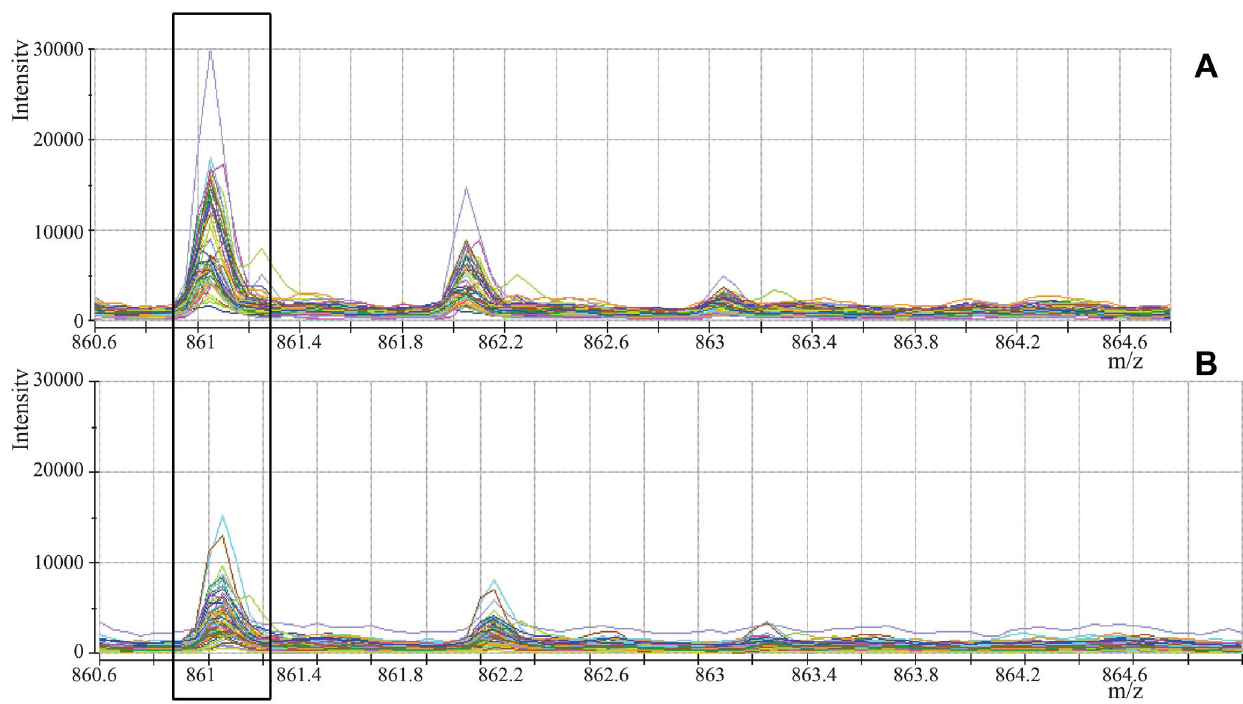
Figure 4. MALDI-TOF MS spectra of the discriminatory peaks. (A) MALDI-TOF MS spectrum of peak1 (861Da) in the disease group. (B) MALDI- TOF MS spectrum of peak1 (861Da) in the control group.